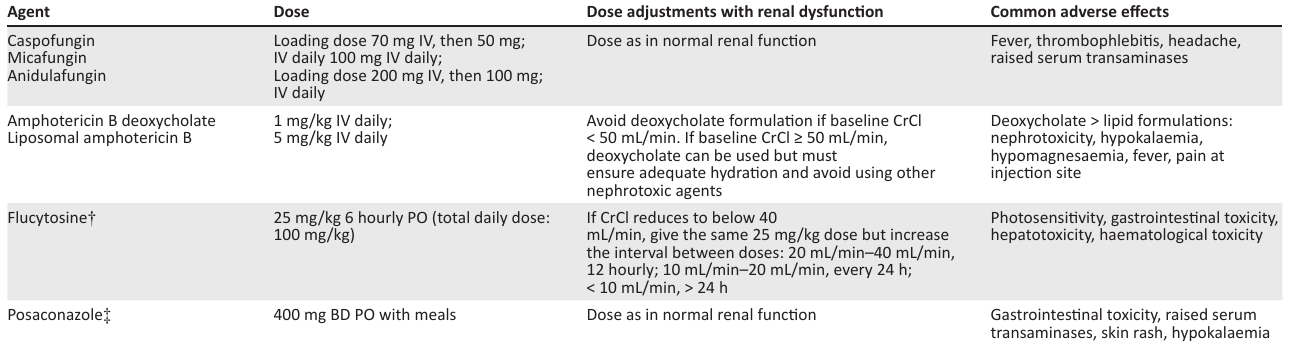
TABLE 5: Antifungal agents for adults with invasive disease. Agent